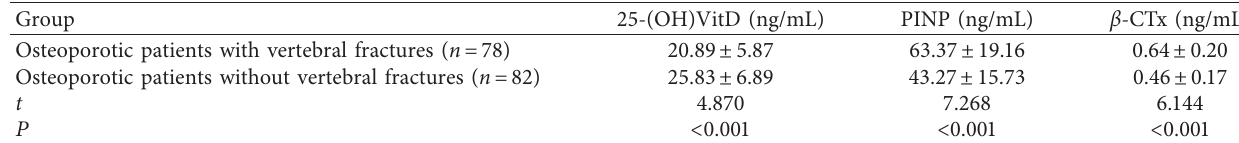
Table 2: The plasma levels of 25-(OH)VitD, PINP, and β -CTx in osteoporotic patients with or without vertebral fractures.